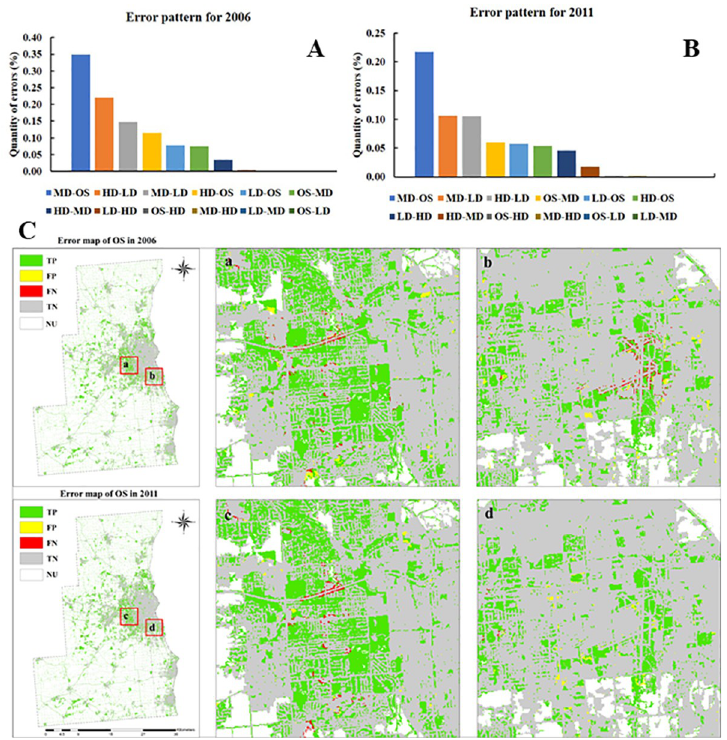
Fig 8. Errors between observed and simulated maps and error maps for open space. (A) Errors between observed and simulated maps as percent of total urban area for 2006. (B) Errors between observed and simulated maps as percent of total urban area for 2011. (C) Error maps for open space for 2006 and 2011.Labels of XX-YY means XX was observed, but predicted to be YY. True positive (TP) represented cells that were predicted to change and did change. False positive (FP) represented cells that were predicted to change but did not change. True negative (TN) represented cells that were predicted to not change and did not change. False negative (FN) represented cells that were predicted to not change but did change. NU represented non-urban areas.